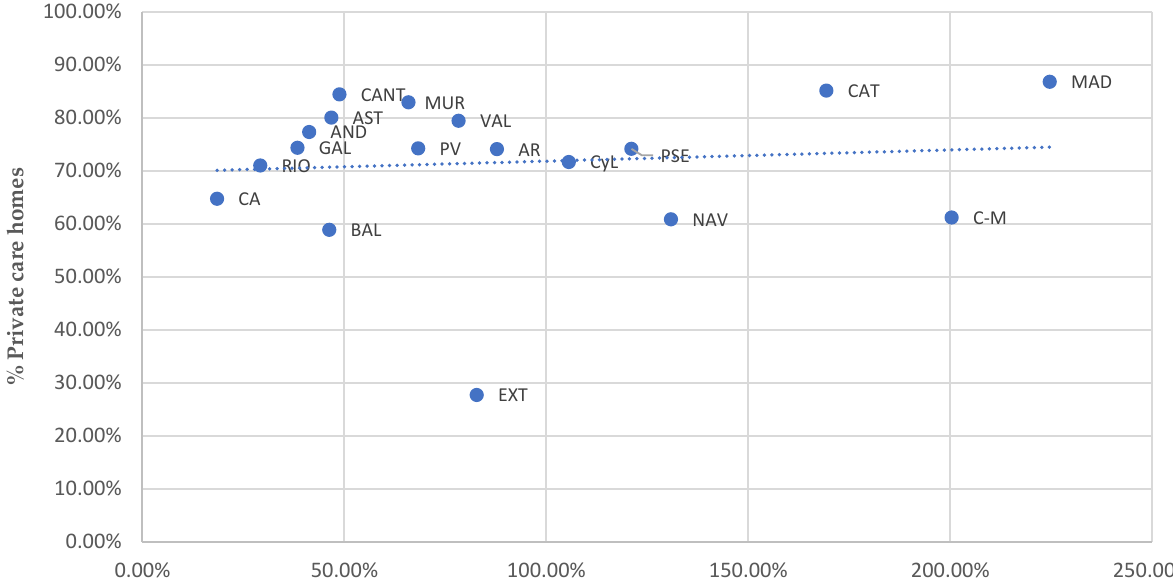
Figure 5. Excess deaths among care home publicly funded bed beneficiaries and type of ownership. Source: Authors’ work using data from IMSERSO